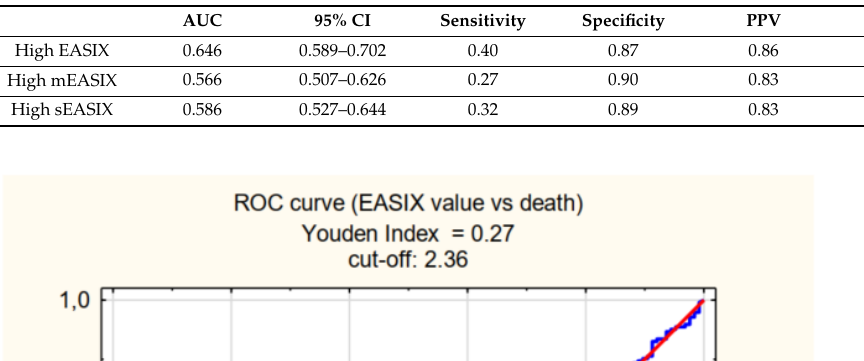
Table 3. Sensitivity, specificity, PPV (positive predictive value), NPV (negative predictive value), AUC for predicting mortality in patients with COVID-19 according to EASIX, mEASIX and sEASIX cut-offs.